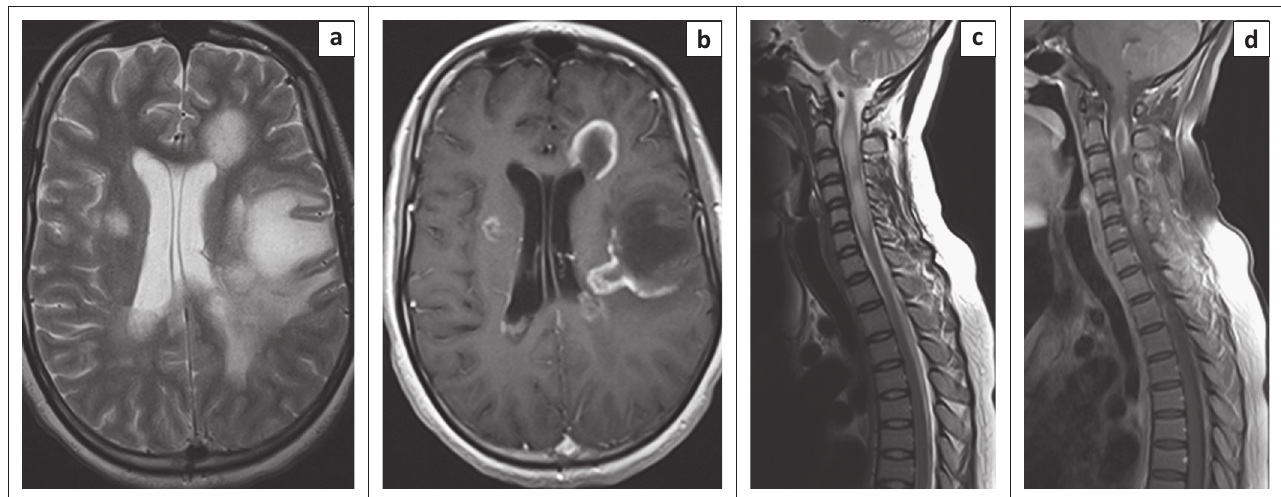
FIGURE 3: Images from an HIV-positive patient (a) and (b) are T2 and T1 post-contrast images of the brain, respectively, showing tumefactive lesions. Figure (c) and (d) are corresponding images of the spinal